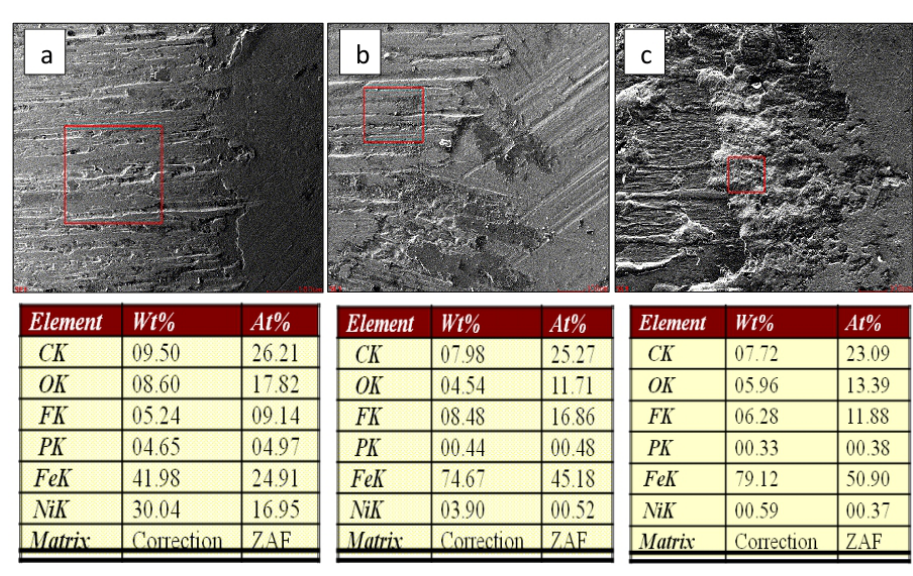
Figure 9. SEM/EDAX results of worn surface of the Ni-P coating at (a) 10 N, (b) 20 N, (c) 30 N loads.